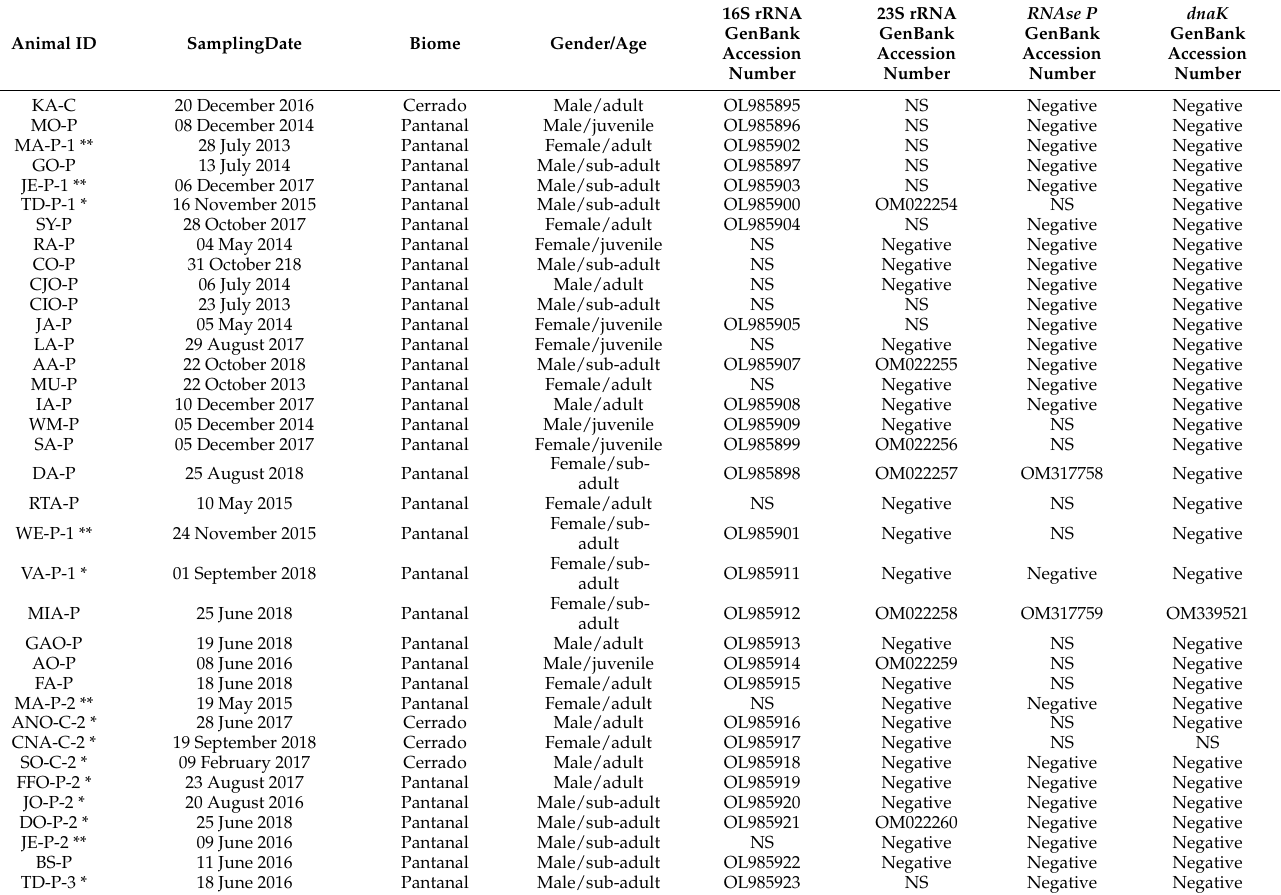
Table 2. Identification, sampling dates, locations, gender/age, and Genbank accession number for each partial 16S rRNA-positive